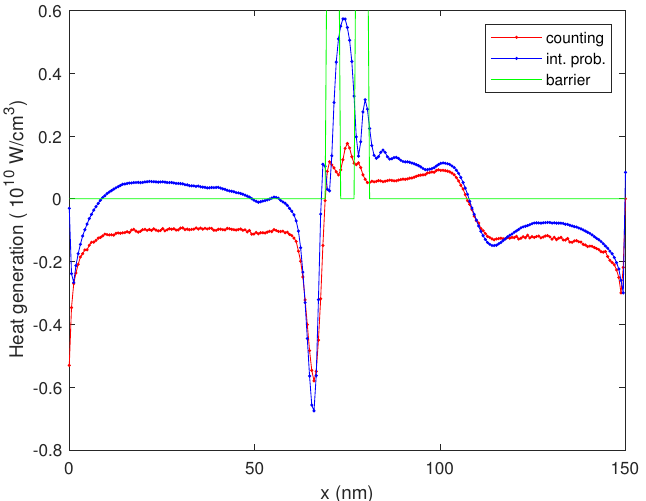
Figure 2. The heat generation rate versus the position for V b = 0.8 V evaluated by means of the counting estimator (30) and the integrated probability estimator